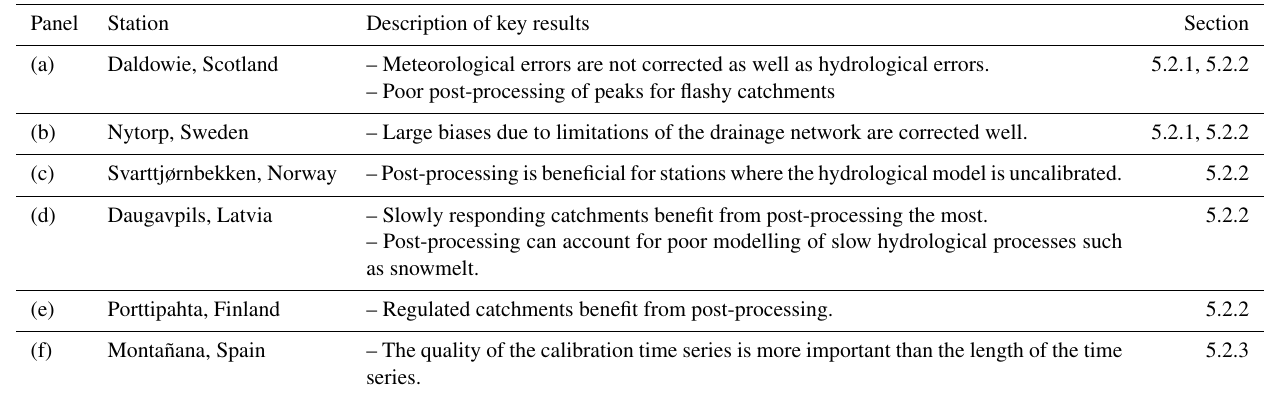
Table 2. Key results and the section that provide more information for each of the six stations used as examples and for which time series are shown in Fig.